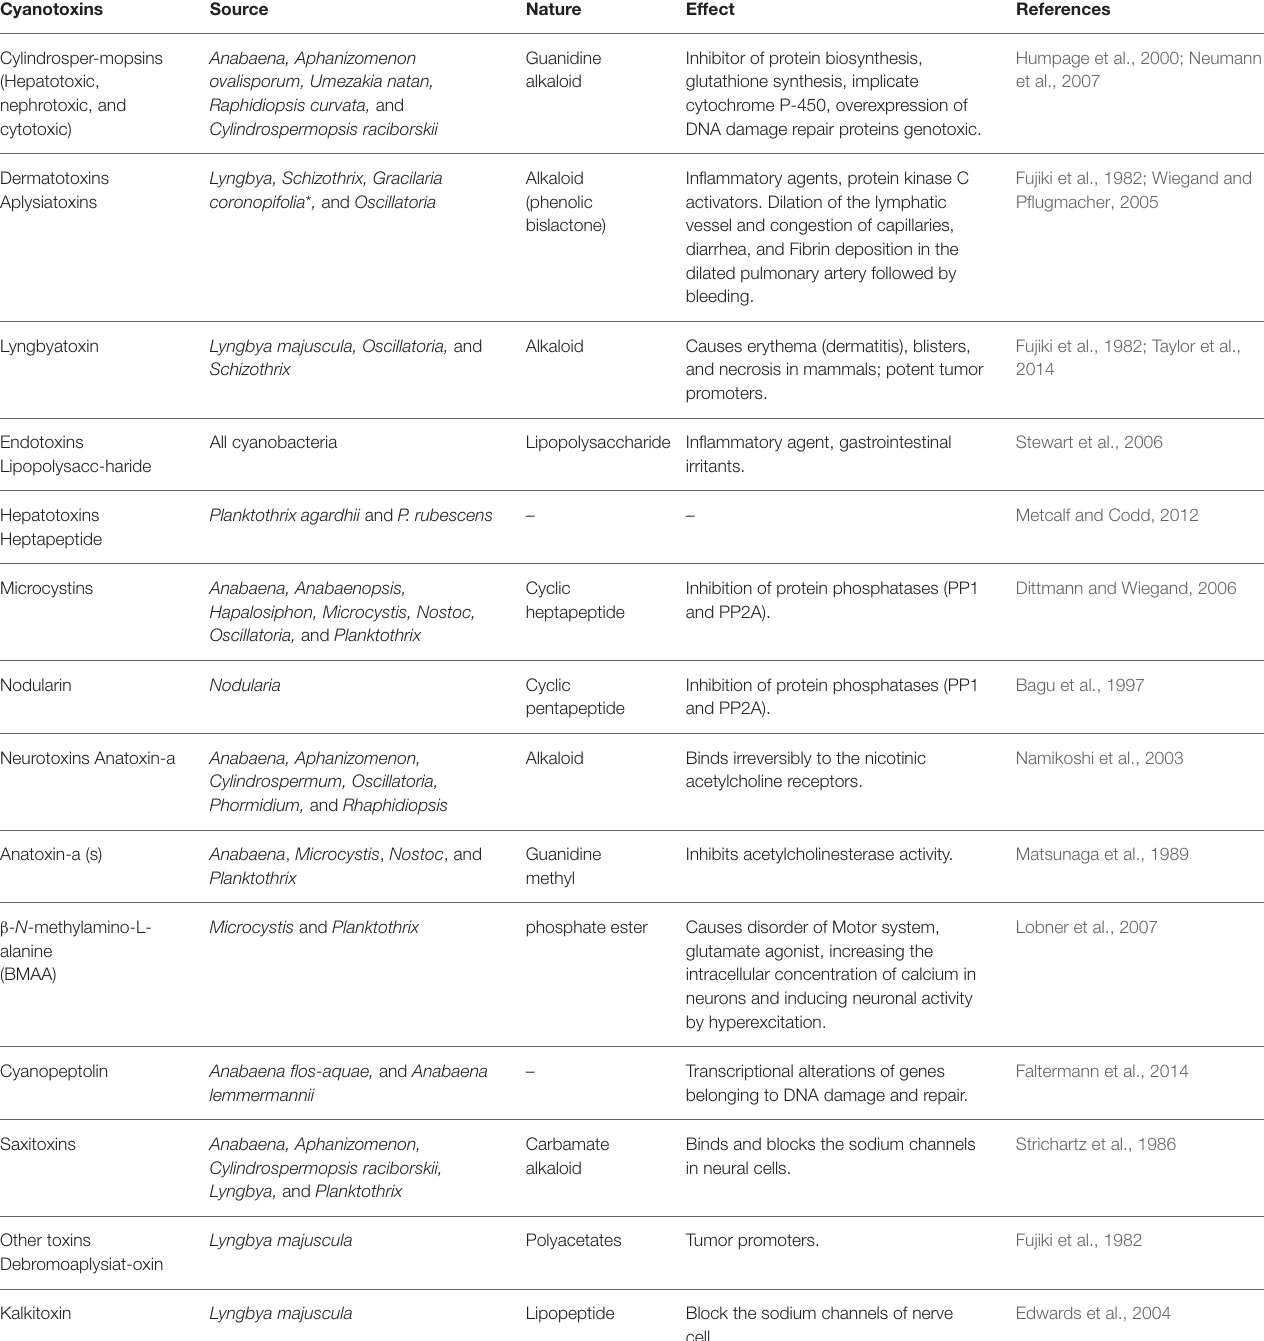
TABLE 3 | An overview of cyanotoxins produced by algae and cyanobacteria and their potential impacts on other organisms.